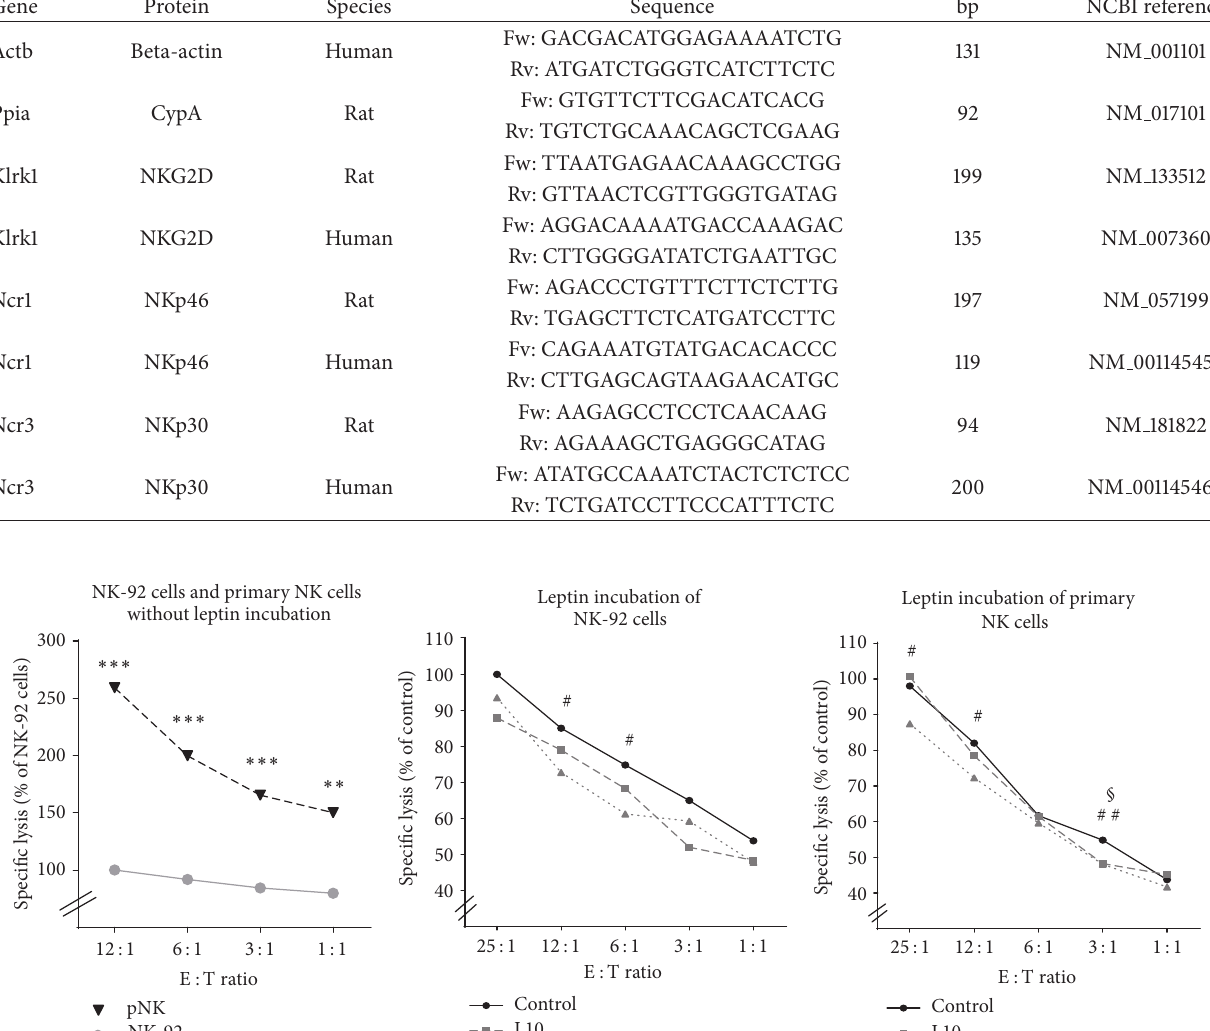
Table 1: Characteristics of the specific primers used for real-time RT-PCR analysis.